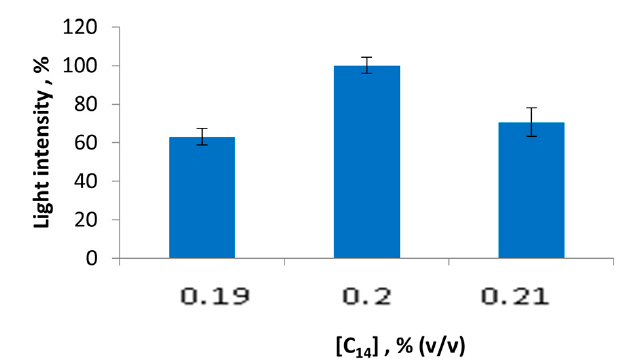
Figure 5. Values of light intensity of the LDH + Red + Luc enzyme system upon the C 14 concentration variation.